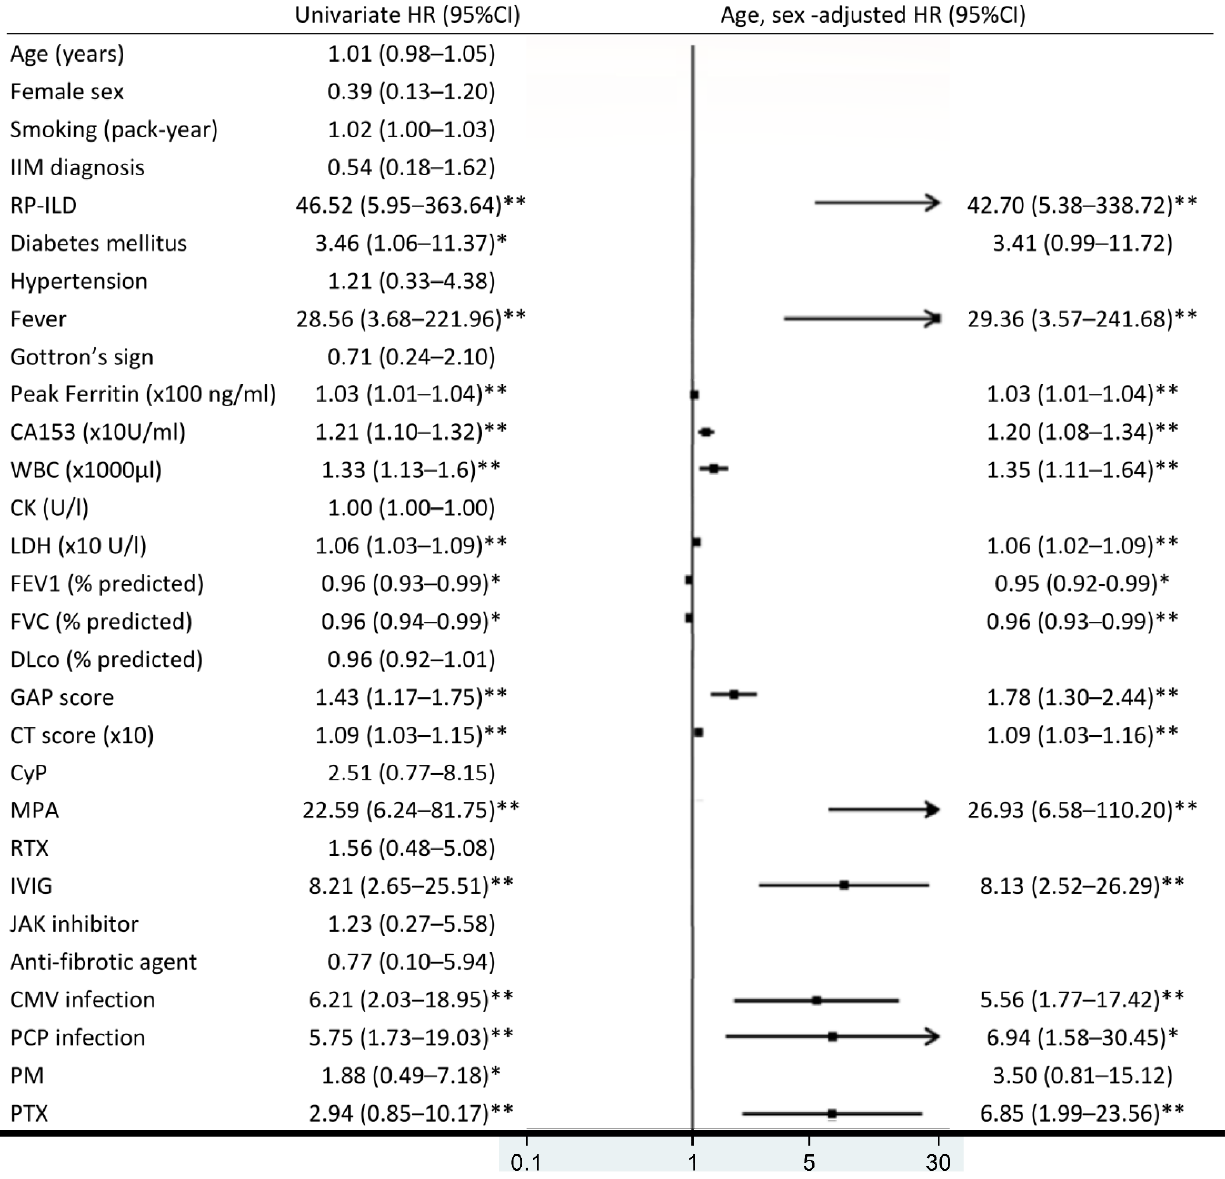
Figure 3. Univariate and age- and sex-adjusted hazard ratio (HR) for mortality. HR plotted in the middle; the 95% confidence intervals presented in parentheses. * p < 0.05, ** p < 0.01.